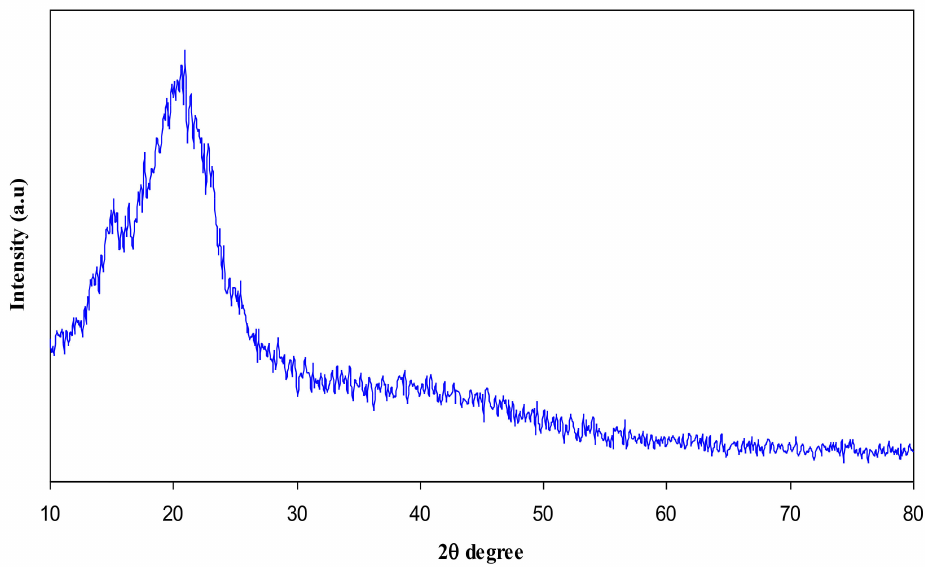
Figure 2. XRD pattern of pure chitosan (CS) polymer.